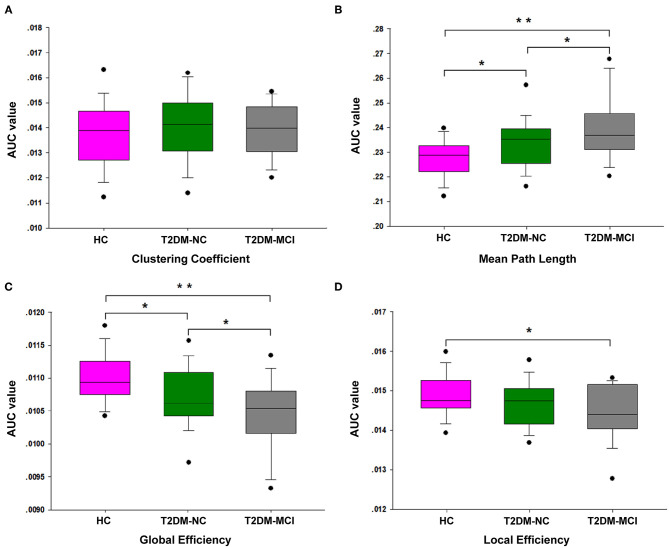
The differences of global network properties. The differences are shown in Cp
(A), Lp
(B), Eglob
(C), and Eloc
(D) among the T2DM-MCI, T2DM-NC, and HC groups. *The significance threshold was set at P < 0.05, **The significance threshold was set at P < 0.001. Cp, clustering coefficient; Lp, shortest path length; Eglob, global efficiency; Eloc, local efficiency.